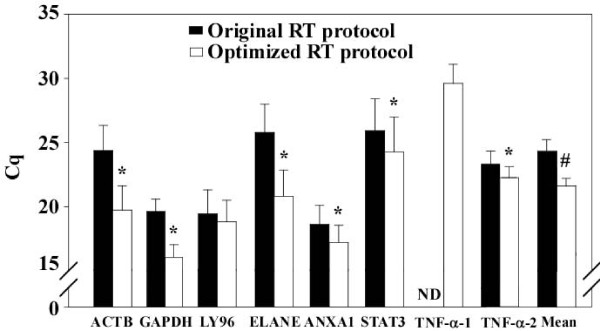
RT protocol optimization decreases qPCR Cq values. Total RNA extracted from blood cells of the same 15 brain-dead organ donors used in Figure 1 was amplified and amino allyl labeled to generate AA-aRNA. 100 ng of each of these AA-aRNA were then reverse transcribed to cDNA using either the original or the optimized RT protocol, and qPCR was applied to assess expression levels of ACTB, GAPDH, LY96, ELANE, ANXA1, STAT3 and TNF-α. Results are represented as Cq values for each gene (mean ± SD of the 15 donors) and as the mean ± SD of the 7 genes. The optimized RT protocol decreased Cq values. ND: not detectable. * P < 0.001 and # P = 0.004 vs original RT protocol (paired t-test).